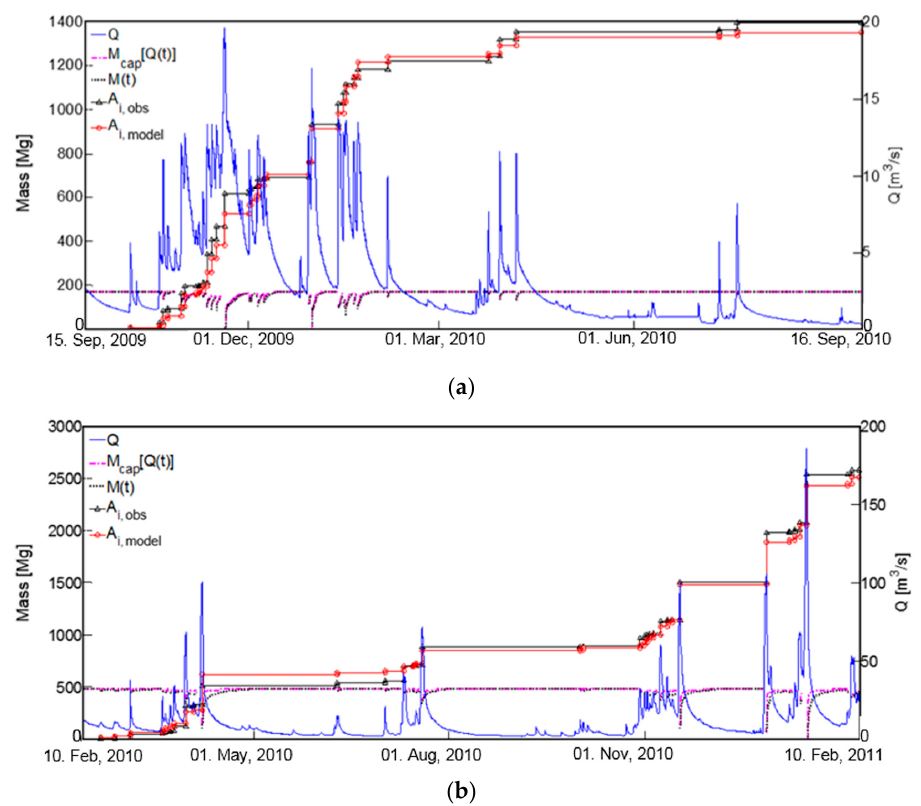
Figure 4. Model calibration output for ( a ) Owenabue from 15 September 2009 to 15 September 2010 and ( b ) Bandon from 10 February 2010 to 9 February 2011. The dashed magenta line represents the storage capacity of the sediment bed for fine sediments, M cap [Q(t)], and the dotted black line represents the mass of the fine sediments stored in the sediment bed, M(t). The black line with triangles represents the observed cumulative mass of fine sediments released from the sediment bed by the first i flood events (A i,obs ) and the red line with circles represents the modeled cumulative mass of sediments released for the first i flood events (A i,model ).